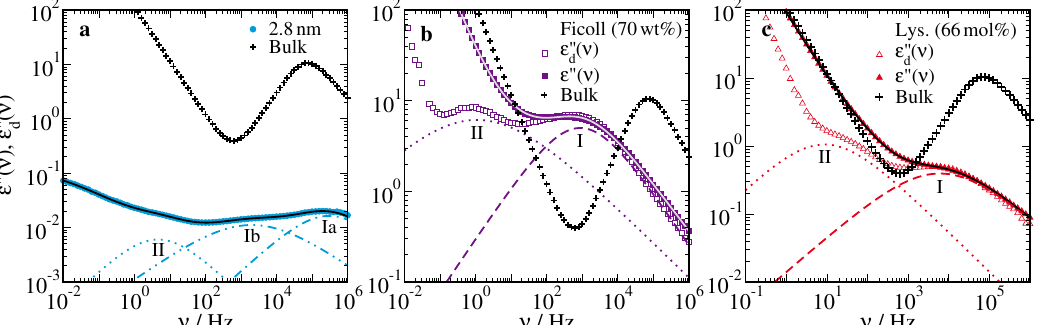
Figure 1. Dielectric loss spectra ε ” ( ν ) of 66mol% D 2 O-DMSO- h 6 solution in ( a ) silica pores with a diameter of d = 2.8nm, ( b ) ficoll at a solution mass fraction of w s = 70wt%, and ( c ) lysozyme at a solvation level of s = 0.68 g sol / g lys . The temperatures are indicated in Kelvin. The colored lines and Roman numbers mark the individual relaxation processes. The insets show the dielectric loss spectra at 200K in an extended frequency range.